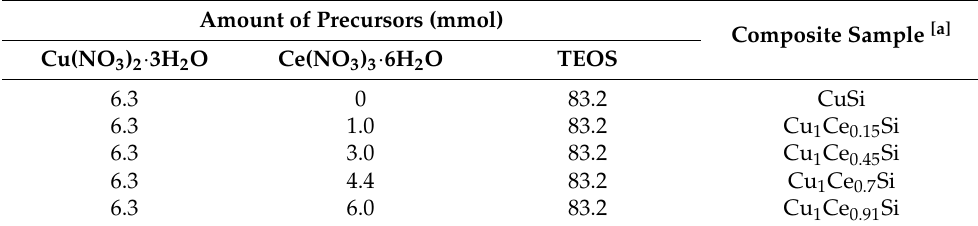
Table 1. Detailed amount of precursors for the preparation of CuO-CeO 2 -SiO 2 composites.